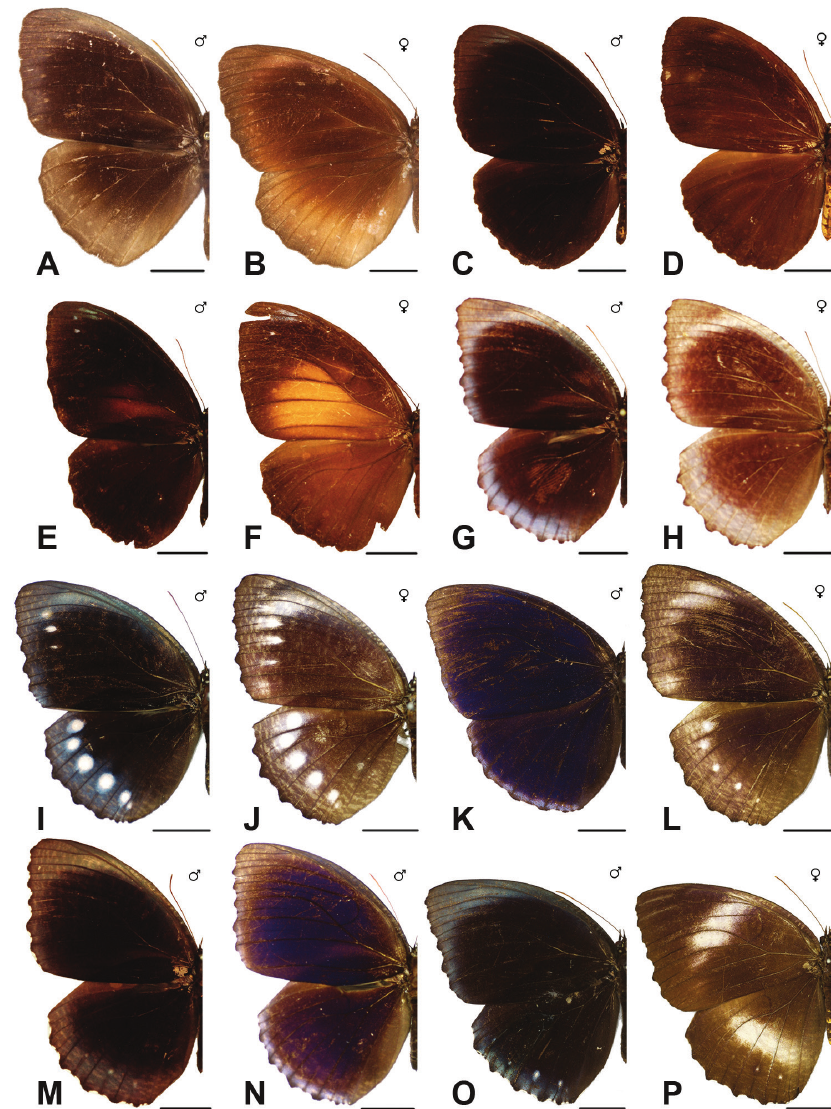
Figure 20. A cybele cybele ♂ D NHM Indonesia: North Maluku, Halmahera B cybele cybele ♀ D NHM Indonesia: North Maluku, Halmahera C cybele cybele ♂ D NHM Indonesia: North Maluku, Bacan D cybele cybele ♀ D NHM Indonesia: North Maluku, Bacan E cybele obiana ♂ D NHM Indonesia: North Maluku, Obi F cybele obiana ♀ D NHM Indonesia: North Maluku, Obi G cumaea cumaea ♂ D NHM Indonesia: North Sulawesi, Menado H cumaea cumaea ♀ D NHM Indonesia: North Sulawesi, Minahasa I hewitsoni hewitsoni ♂ D NHM Indonesia: South Sulawesi J hewitsoni hewitsoni ♀ D NHM Indonesia: South Sulawesi K mimalon mimalon ♂ D NHM Indonesia: Sulawesi L mimalon mimalon ♀ D NHM Indonesia: North Sulawesi, Menado M mimalon nysa ♂ D NHM Indonesia: South Sulawesi N mimalon ino ♂ D NHM Indonesia: Central Sulawesi; Holotype O hicetas hicetas ♂ D NHM Indo- nesia: Sulawesi P hicetas hicetas ♀ D NHM Indonesia: South